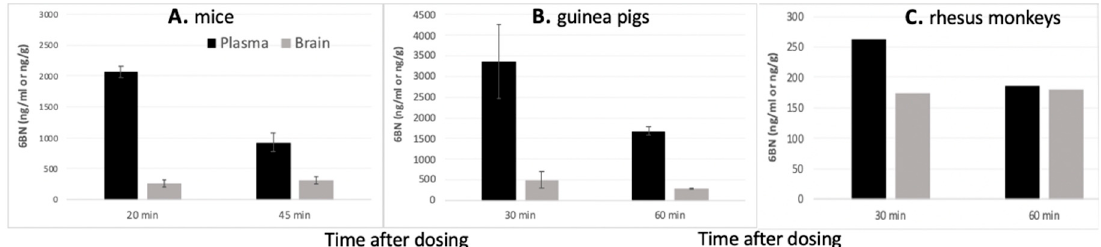
Figure3. Maternalplasmaandbrainlevelsof6BNinadultfemalepregnantmice, guineapigs, andrhesus Figure 3. Maternal plasma and brain levels of 6BN in adult female pregnant mice, guinea pigs, and monkeys. ( A ) 6BN levels in mice at 20 and 45 min after injection (10 mg / kg, s.c.) (data from [42]). rhesus monkeys. ( A ) 6BN levels in mice at 20 and 45 min after injection (10 mg/kg, s.c.) (data from ( B ) 6BN levels in guinea pigs at 30 and 60 min after injection (10 / mg / kg, s.c.) (data from [43]). ( C ) 6BN [42]). ( B ) 6BN levels in guinea pigs at 30 and 60 min after injection (10/mg/kg, s.c.) (data from [43]). levels in rhesus monkeys at 30 and 60 min after injection (2 mg / kg, i.v.) (J. Oberdick, unpublished; n = 1 ( C ) 6BN levels in rhesus monkeys at 30 and 60 min after injection (2 mg/kg, i.v.) (J. Oberdick, at each time point; a range of 6BN doses and regimen gave similar unpublished; n = 1 at each time point; a range of 6BN doses and regimen gave similar results).